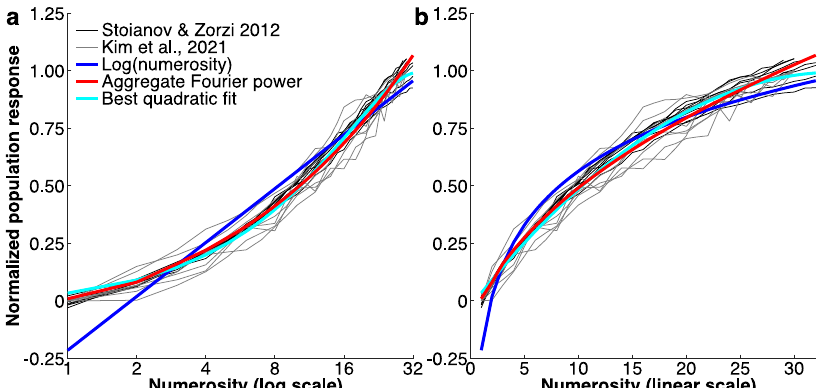
Fig. 6 Comparison between the monotonic responses in neural network models of numerosity processing and the relationship of numerosity to aggregate Fourier power. a Shown on a log numerosity scale, following Stoianov and Zorzi 22 . b Shown on a linear scale following Kim and colleagues 24 . Responses shown in neural network studies (black and gray lines) are fi t very closely by the relationship between numerosity and aggregate Fourier power (red), more closely than by log(numerosity) (blue), and similarly to the best quadratic fi t to these responses (cyan). Source data are provided as a Source Data